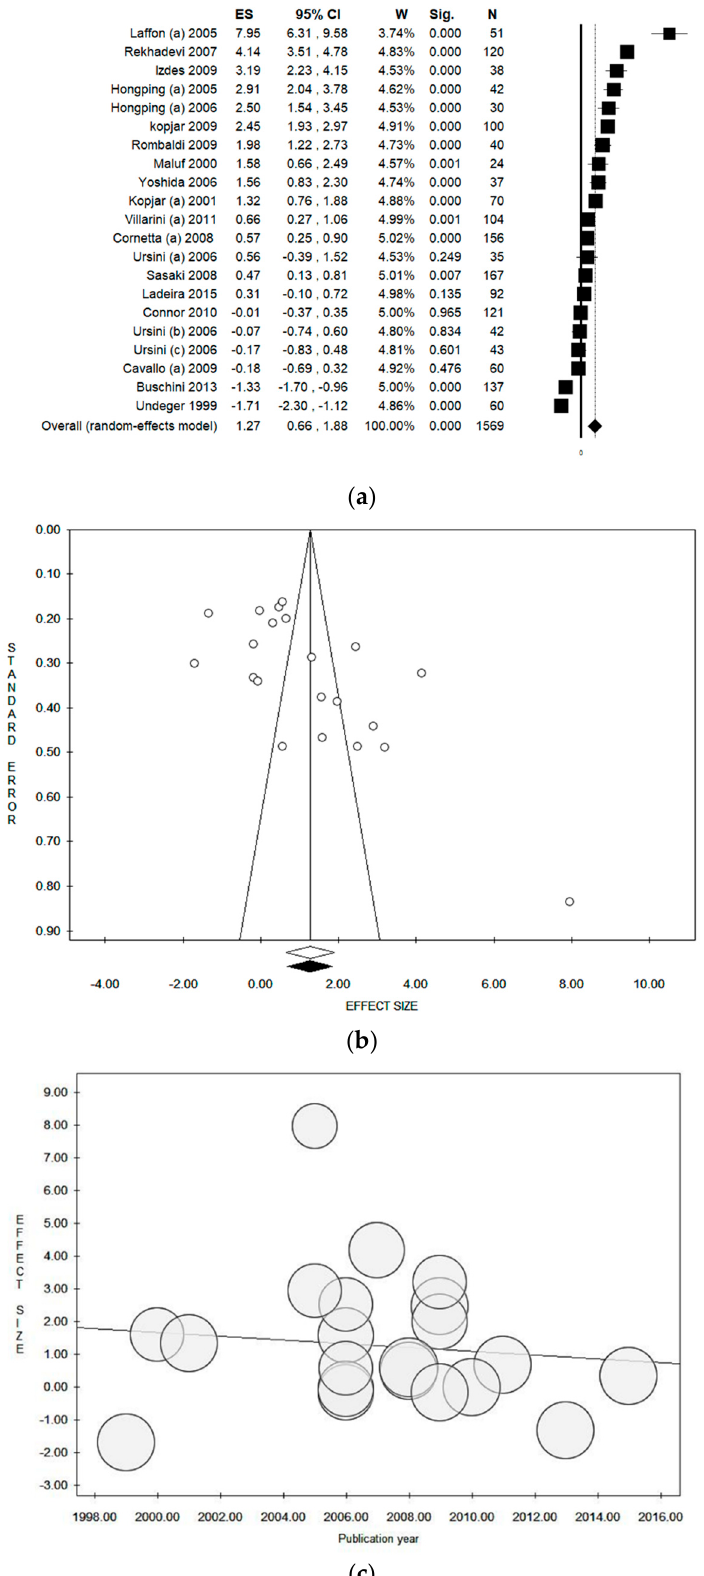
Figure 2. ( a ) Forest plot, ( b ) funnel plot, and ( c ) publication year plot of the meta-analysis assessing the comet assay on lymphocytes cells among professionals occupationally exposed to antineoplastic drugs (ANDs). ES, effect size; CI, confidence interval.